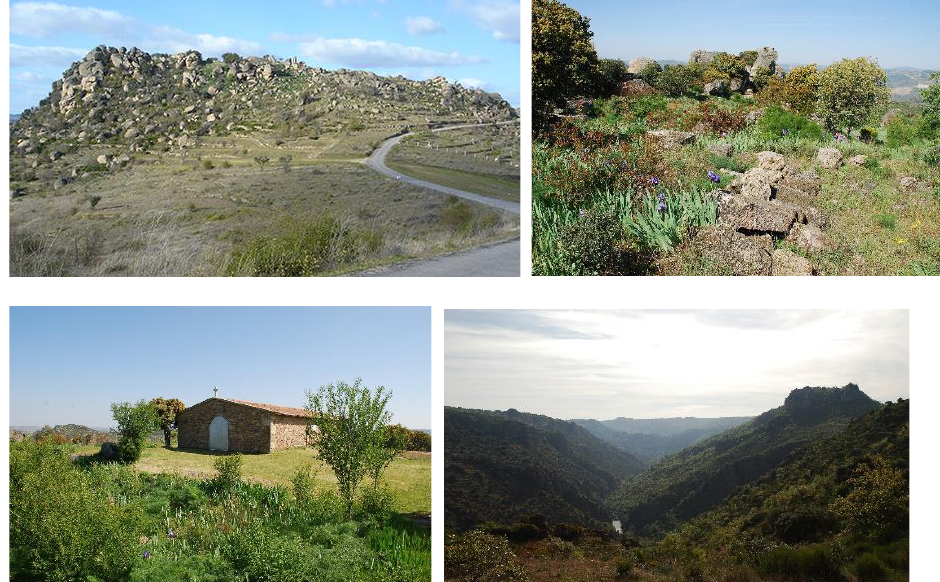
Figure 2. Images of the Teso de San Cristóbal, Villarino de los Aires, Salamanca, Spain (photos by J.A. González).